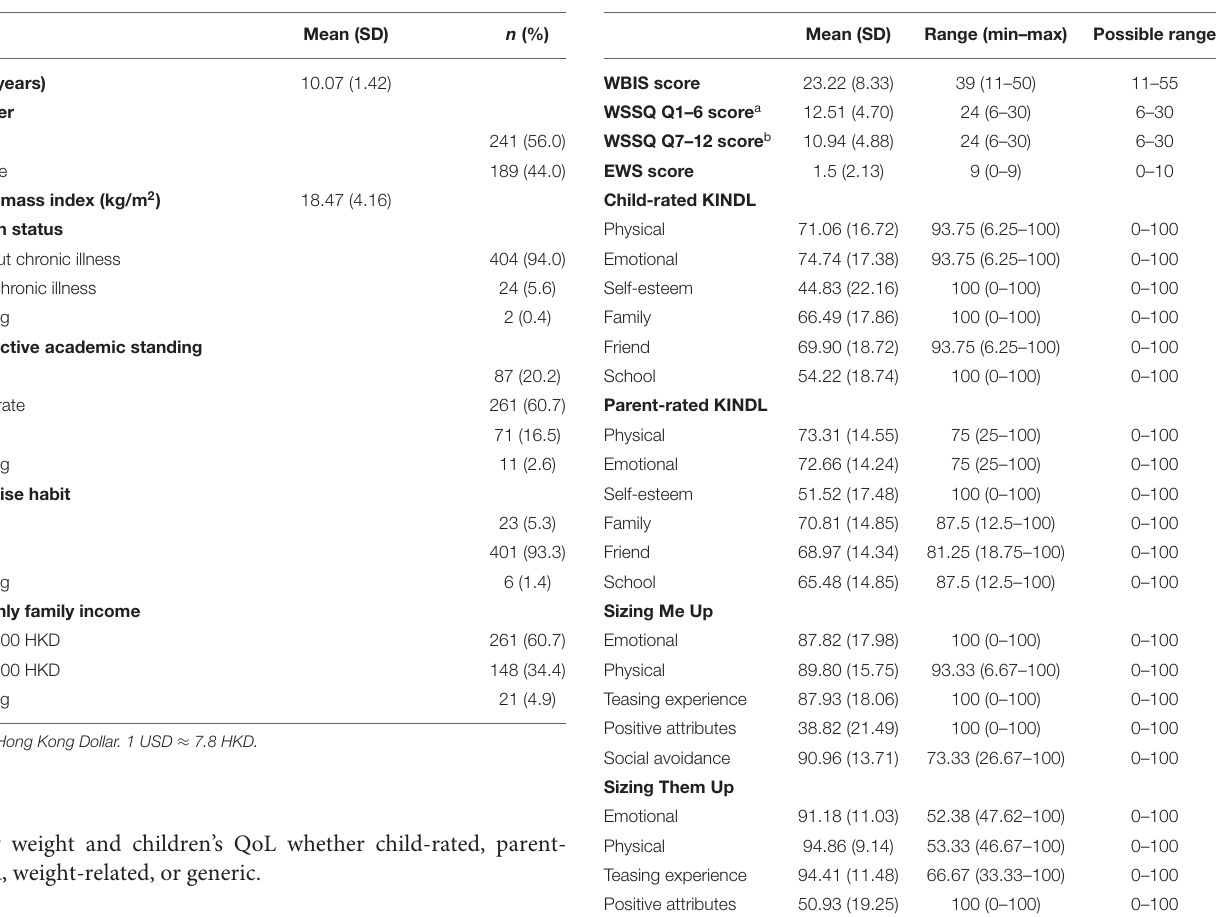
TABLE 1 | Participant characteristics. TABLE 2 | Weight bias and quality of life among